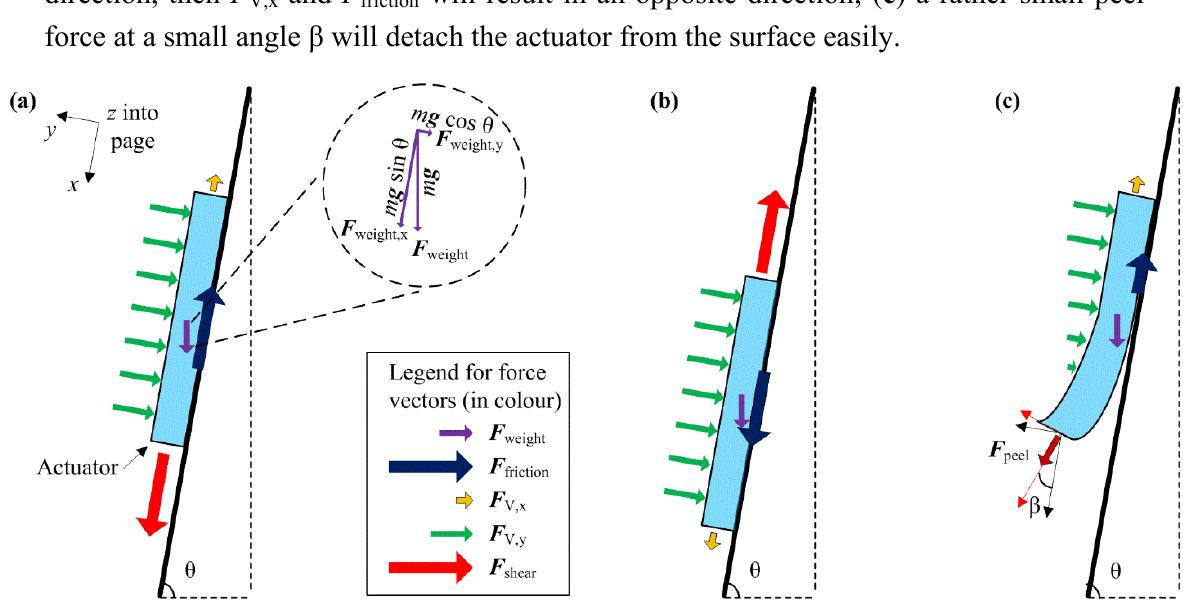
Figure 5. Free body diagrams of the actuator applied to an inclined vertical